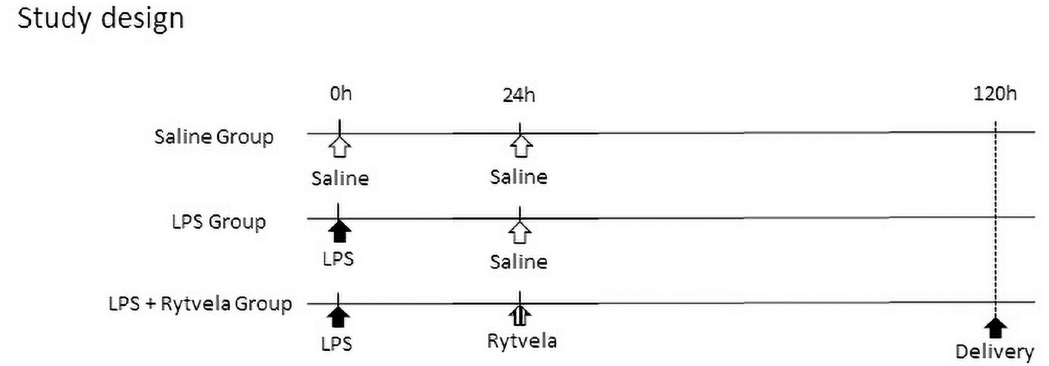
Fig 1. Study design. The LPS Group and the LPS + Rytvela Group animals received an IA injection of 10 mg LPS at 0 hour. The Saline Group animals received an equivalent volume of saline solution. The LPS + rytvela Group received both IA and fetal intravenous injection of rytvela at 24 hours after LPS exposure. The Saline Group and the LPS Group animals received an equivalent volume of saline solution. IA, intra-amniotic; LPS, lipopolysaccharide; MCP, monocyte chemoattractant protein.